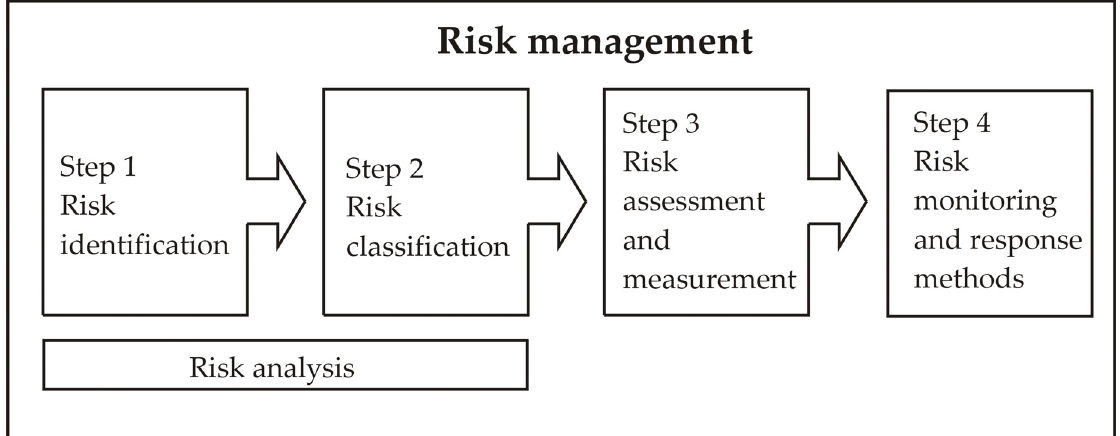
Figure 1. Risk management stages (own study based on (May 2014; Deptu ł a and Knosala